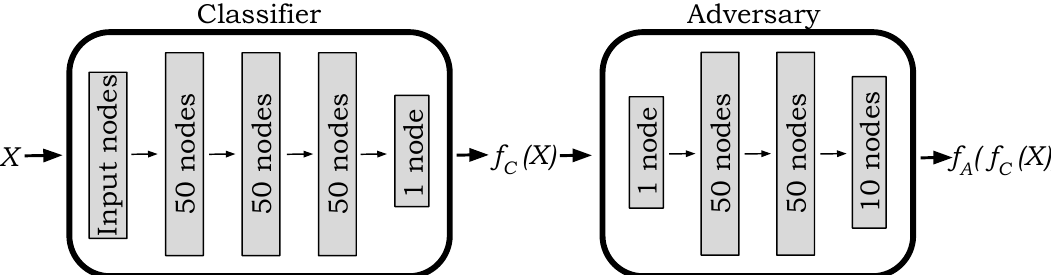
Figure 10: The setup of our adversarially trained neural network. The classifier has the same hyperparameters as in Fig. 3. The output of the classifier becomes the input of the adversary, which attempts to predict which bin of the jet mass the QCD events came from. We use tanh activation for the hidden layers of the adversary, and softmax activation for the final layer, with 10 outputs. The multi-class cross entropy loss function is used for the